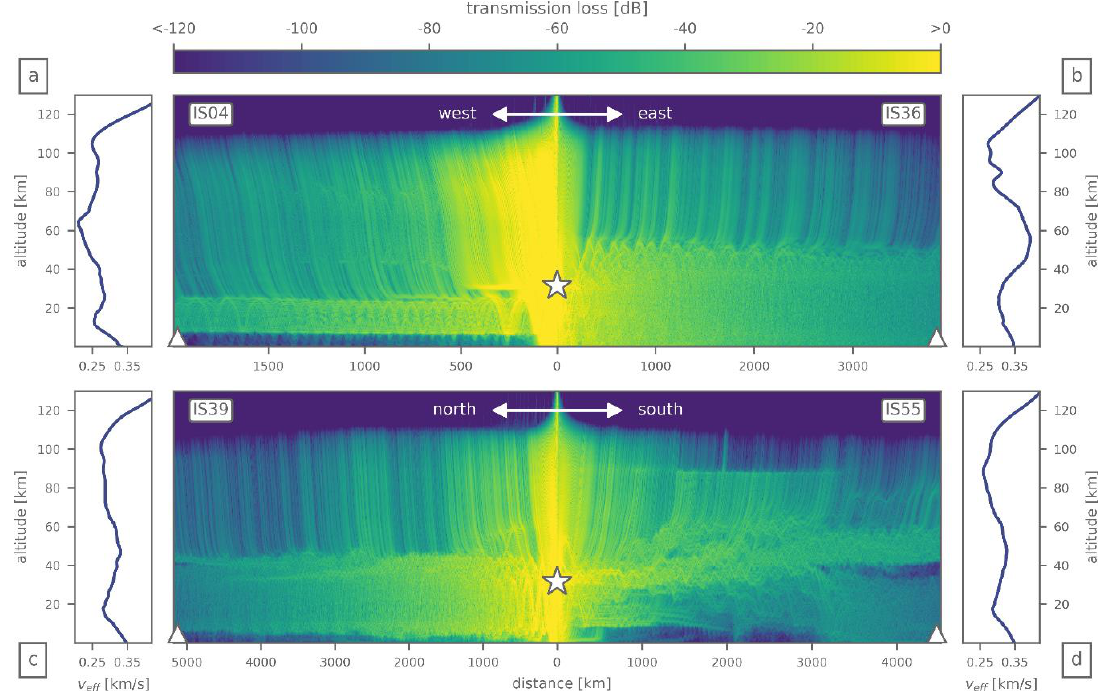
Figure 5. Propagation modeling using range-dependent parabolic equation (PE) from the Great Australian Bight fireball at 31.5 km altitude (star) towards stations (triangles) in the four different cardinal directions, namely ( a ) IS04 to the west, ( b ) IS36 to the east, ( c ) IS39 to the north, and ( d ) IS55 to the south. Color-coded is the transmission loss in dB relative to 1 km reference distance. Different source-to-station distances on the x-axes have to be noted. Average effective sound speed profiles (combining temperature and wind along the propagation path) are provided for each station.